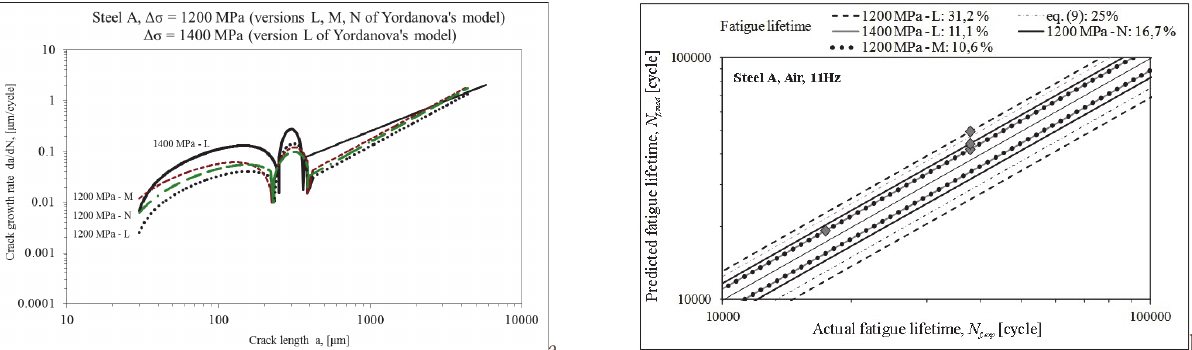
Figure 3: Steel A tested at Δσ = 1200 MPa (L, M and N versions) and Δσ =1400 MPa (L version): (a) Comparison between the new parabolic-linear model; (b) Comparison between experimental and predicted fatigue lifetimes and the corresponding error bands in